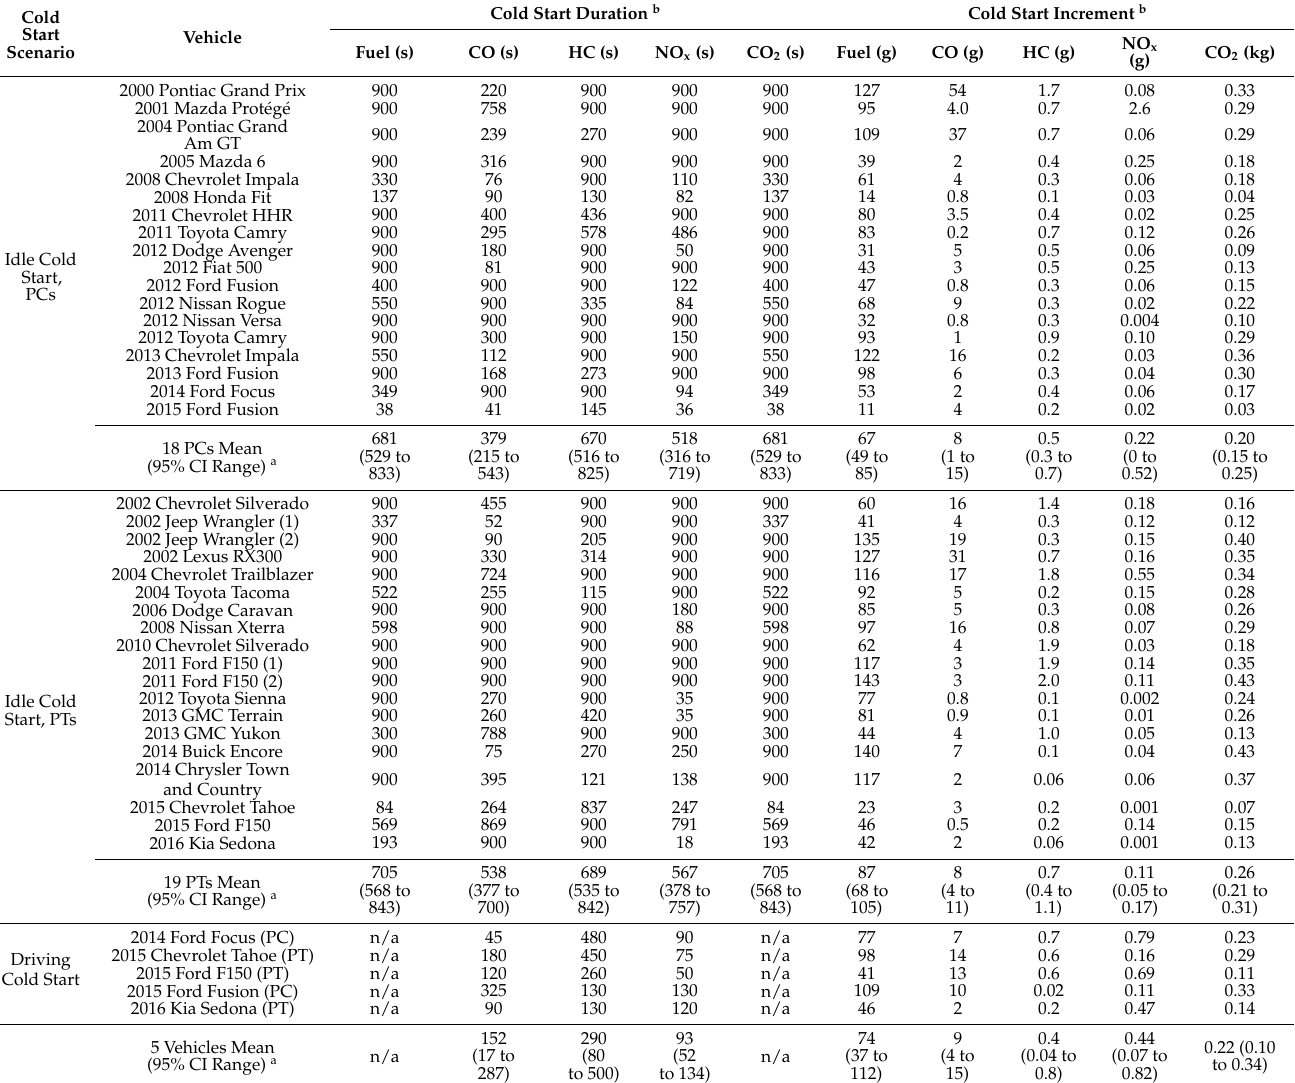
Table 1. Measured idle and driving cold start duration and increment for passenger cars and passenger